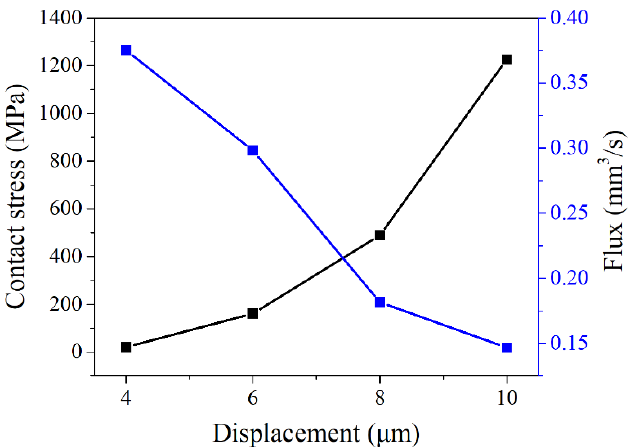
Figure 10. The relationship between the loading displacement and the contact stress and leakage rate of gasket.